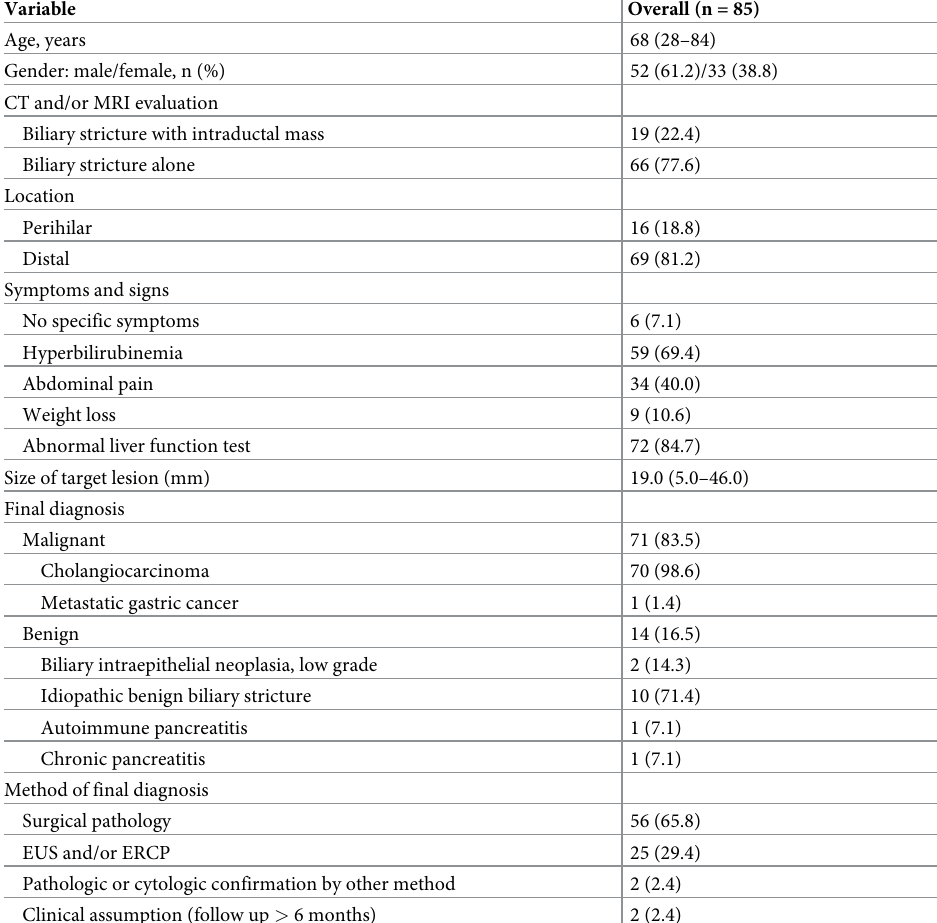
Table 1. Baseline characteristics of